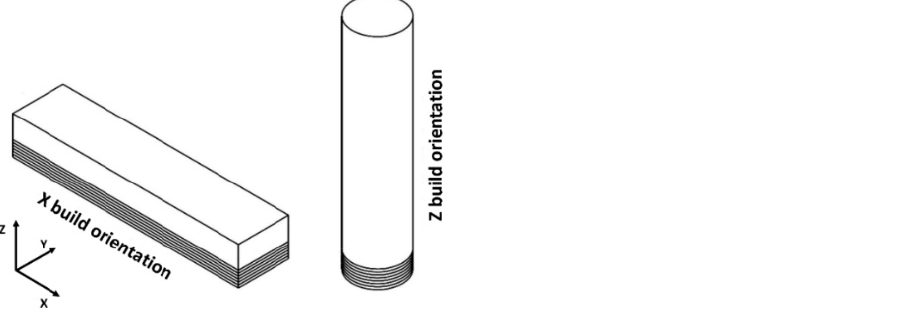
Figure 1. Representation of the build orientations of the samples and the blank geometries. The first layers of the SLM process are depicted. The drawings are not to scale.